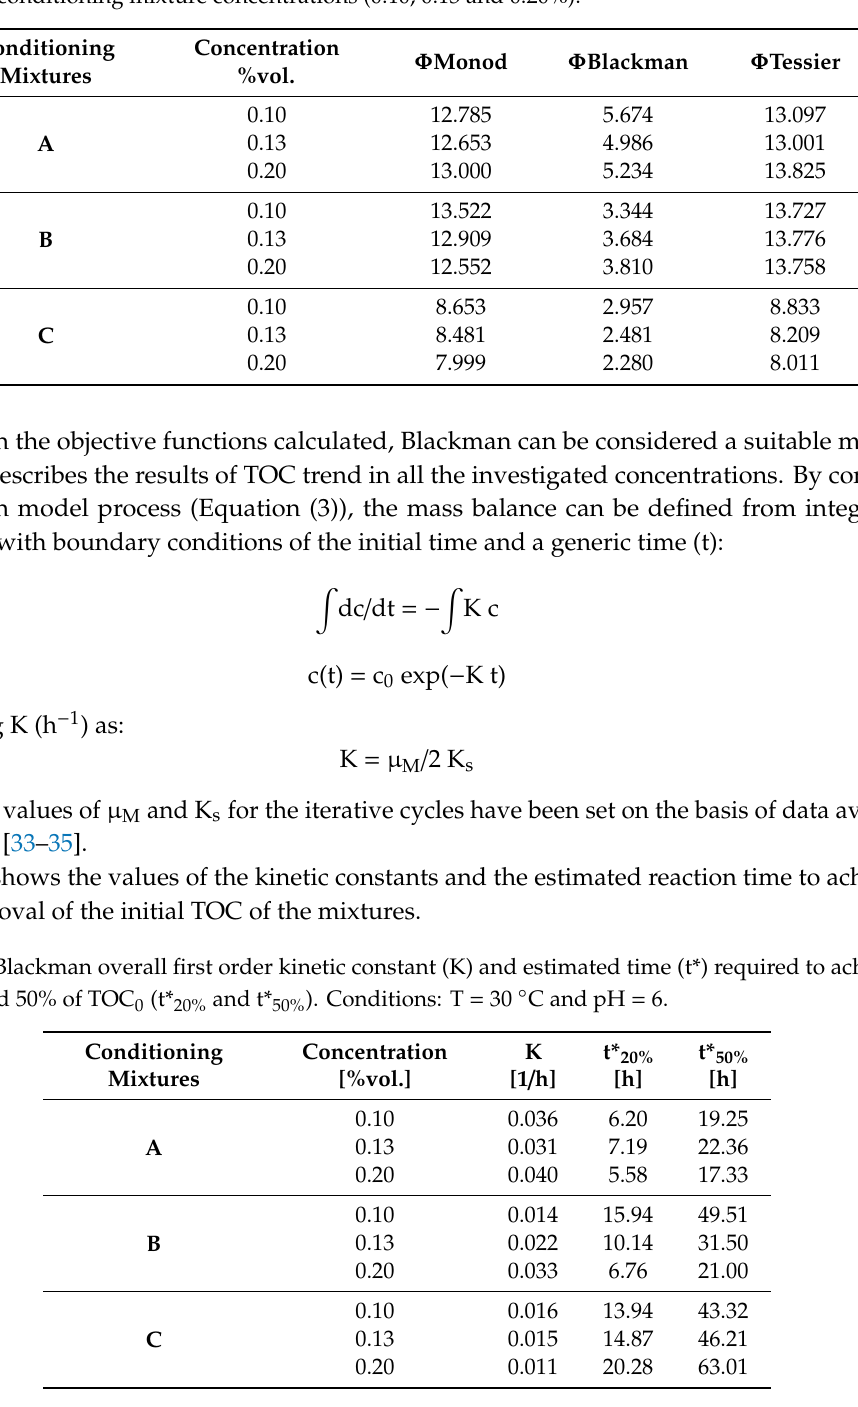
Table 2. Objective function value TOC data fitting by the Monod, Blackman and Tessier models at di ff erent conditioning mixture concentrations (0.10, 0.13 and 0.20%).